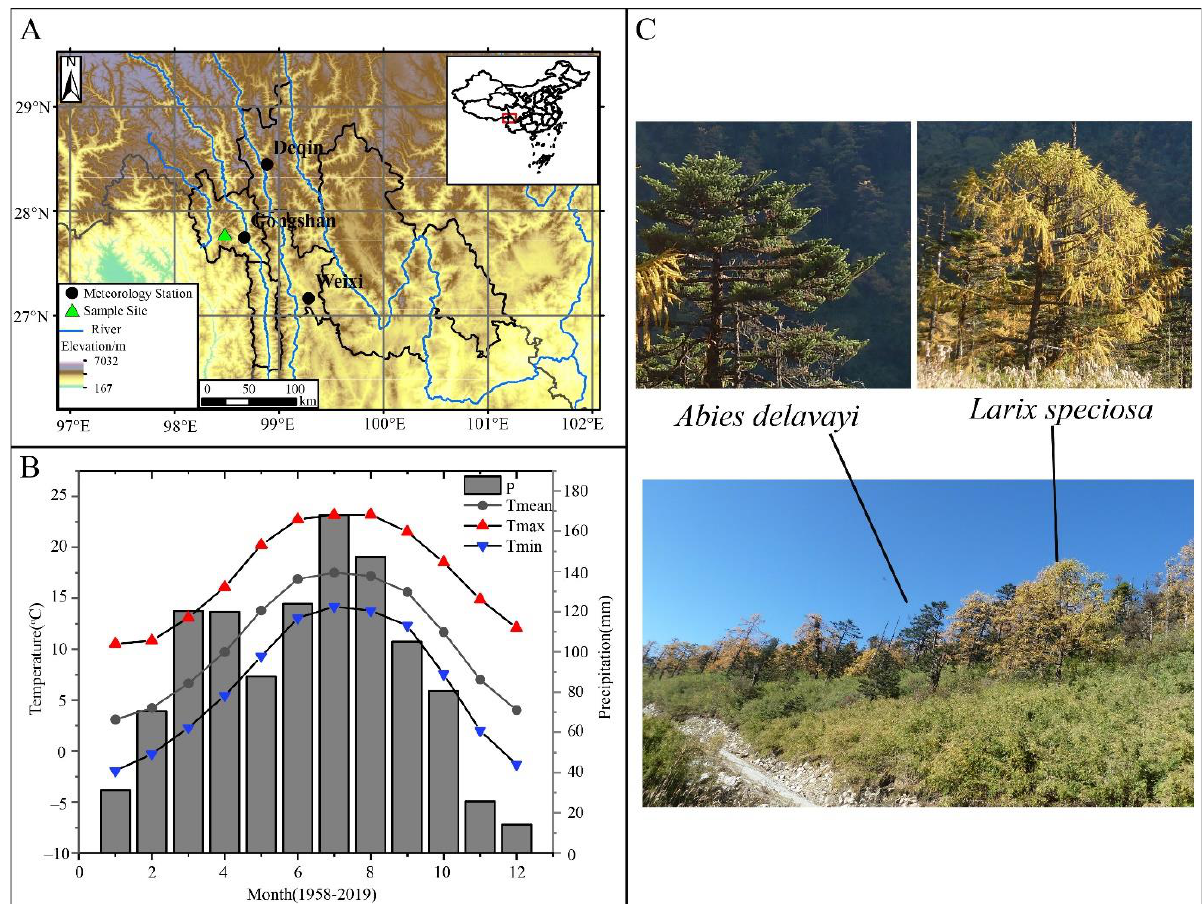
Figure 1. Geography of the study area. ( A ) The location of sampling site within the northwestern Yunnan, China region. ( B ) Climate diagram of the mean values of the meteorological stations in Gongshan, Deqin, and Weixi. P, monthly precipitation; Tmax, monthly mean maximum temperature; Tmin, monthly mean minimum temperature; Tmean, monthly mean temperature. ( C ) Images of the L. speciosa and A. delavayi mixed forest.